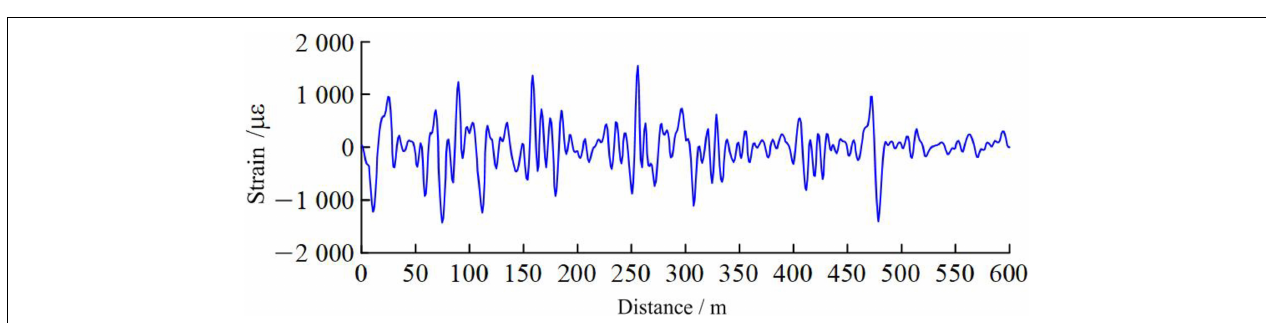
FIGURE 9 | Butterworth low-pass filters of the optical fiber data comparison between 12.01.2019 and 07.01.2020.